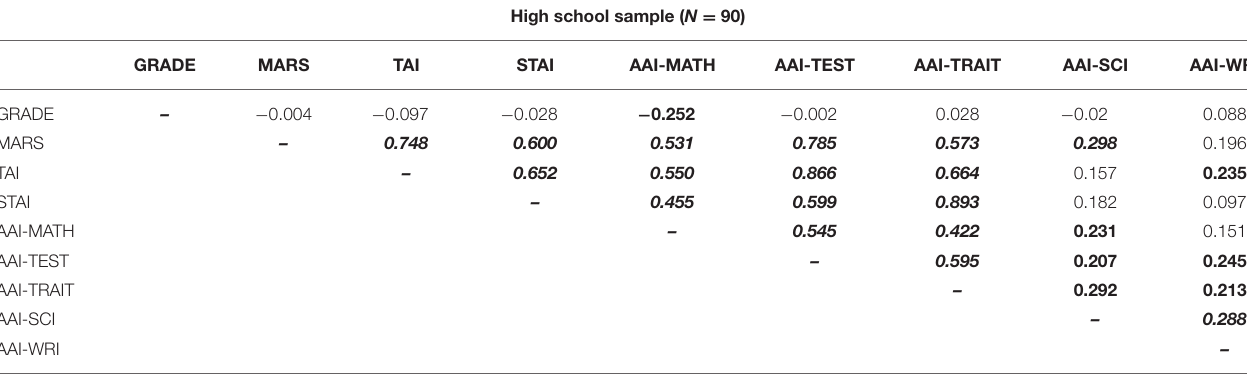
TABLE 7 | Pearson correlations between AAI subscales, established measures of math, trait and test anxiety, and midterm grades for Study